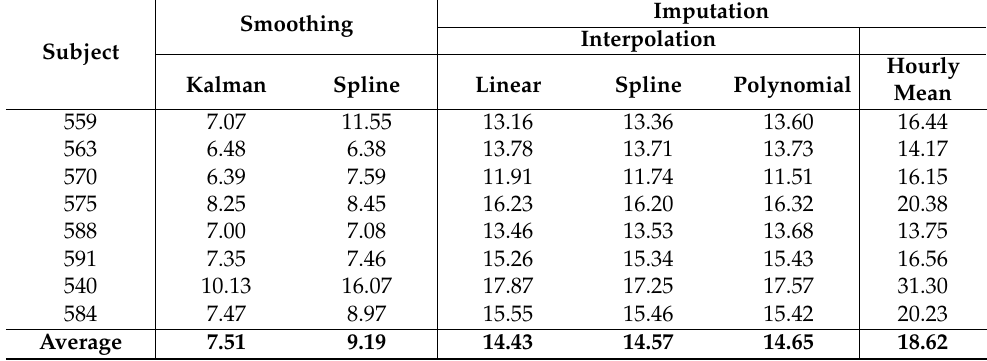
Table 4. RMSE for predicting glucose level using univariate XGBoosting after